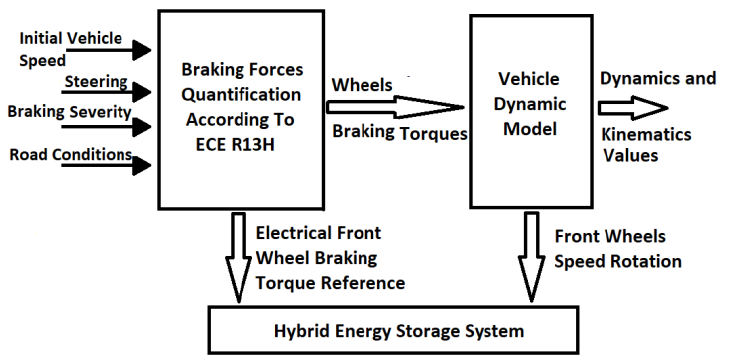
Figure 13. General overall system.